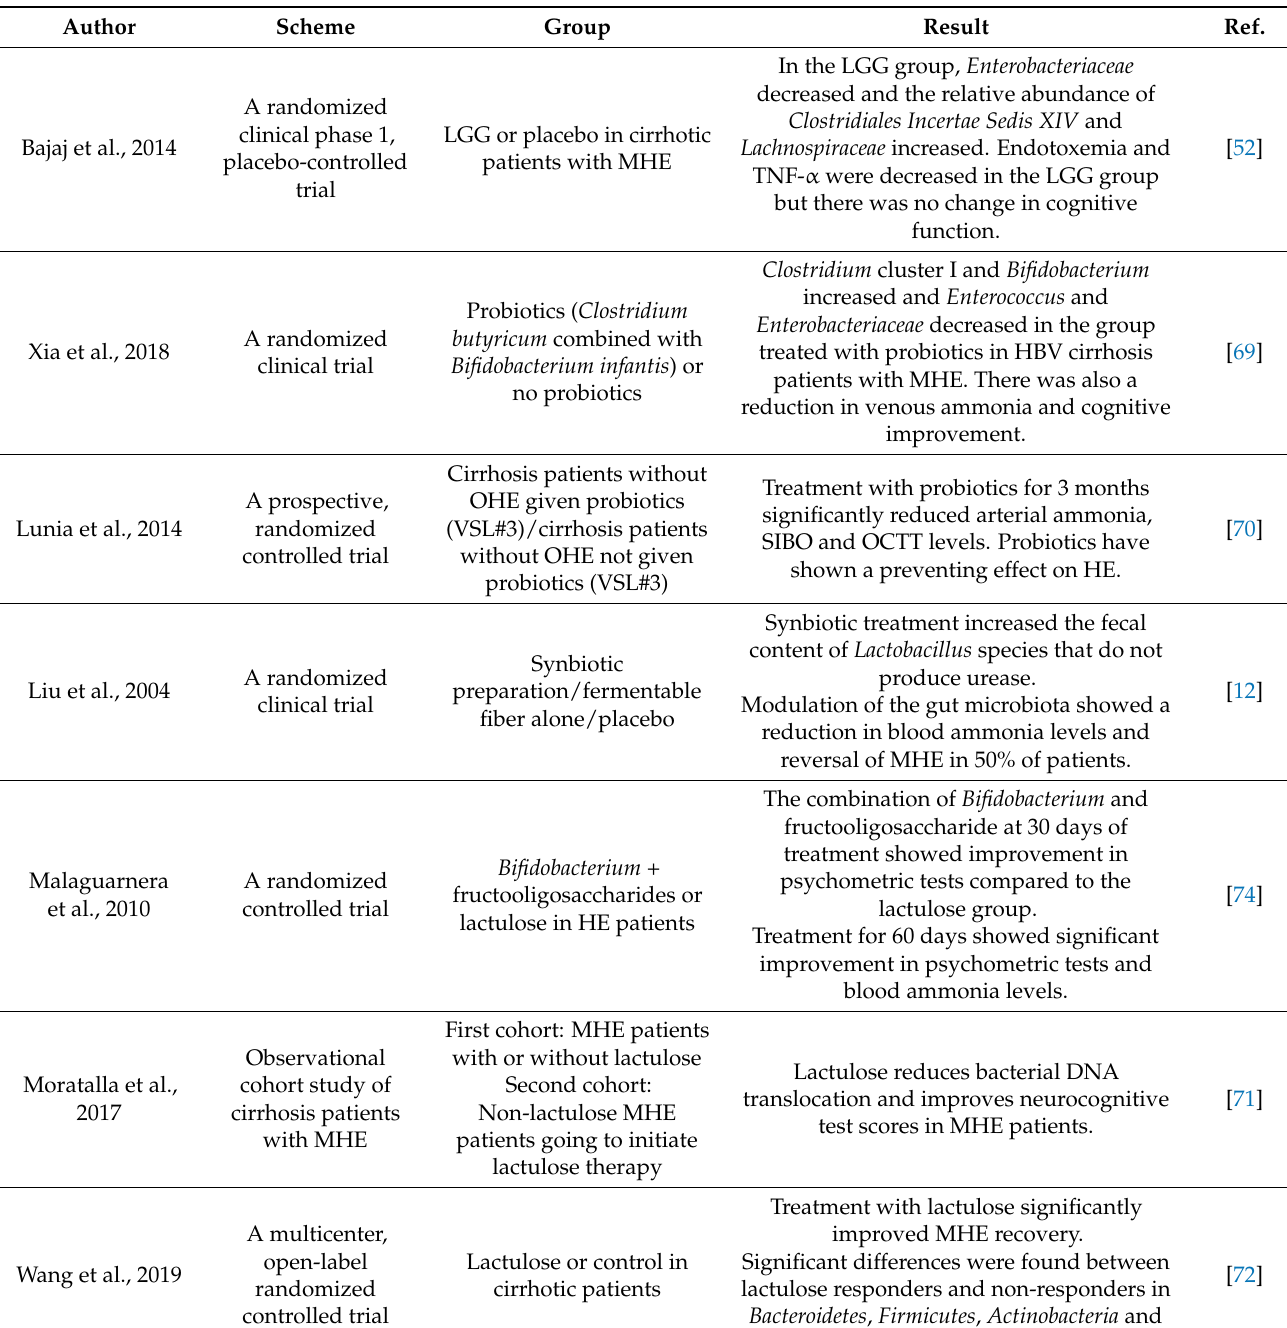
Table 2. Probiotics and prebiotics therapies for hepatic